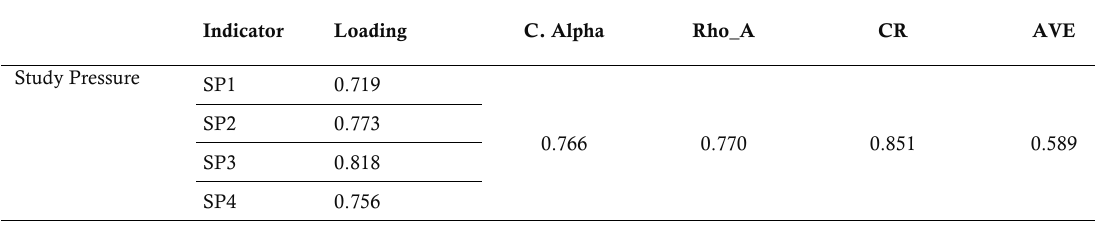
Table 1. Loadings, reliability estimates, and convergent